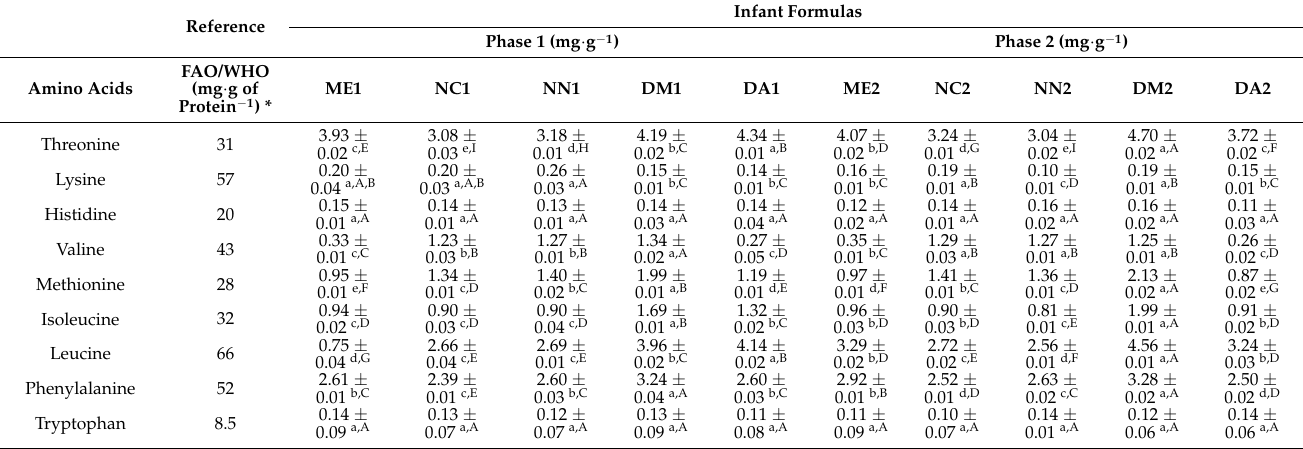
Ten different infant formulas marketed in Brazil were analyzed by HPLC. Analyzes were performed in triplicate and data are reported as means ± SD. Different superscript lowercase letters within the same line indicate significant differences between infant formulas of the same phase at a significance level p < 0.001. Different superscript uppercase letters within the same line indicate significant differences between phase 1 and phase 2 infant formulas at a significance level p < 0.01. * Recommended amino acids daily intake for children aged 0 to 12 months (Joint WHO/FAO/UNU Expert Consultation,